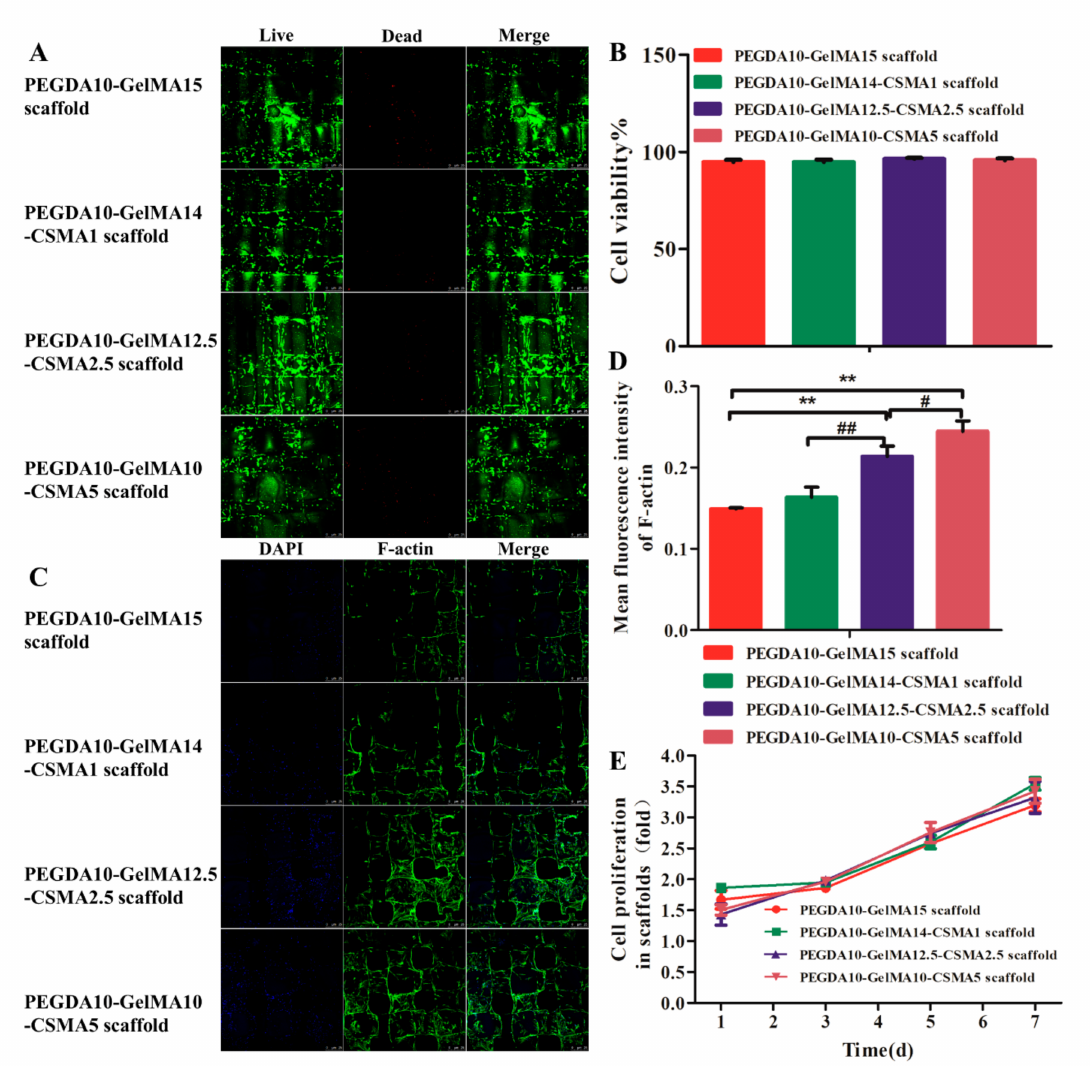
Figure 3. The cytocompatibility of 3D-printed scaffolds. ( A ) Live/dead staining images. ( B ) Percentage of live cells detected by Live/Dead staining. The live cells are indicated by green staining, while dead cells are shown as red. ( C ) Cytoskeletal staining images. ( D ) mean fluorescence intensity of F-actin. ( E ) CCK-8 assay. The scale bar is 25 µ m ( n = 3; ** p < 0.01, ## p < 0.01, # p <